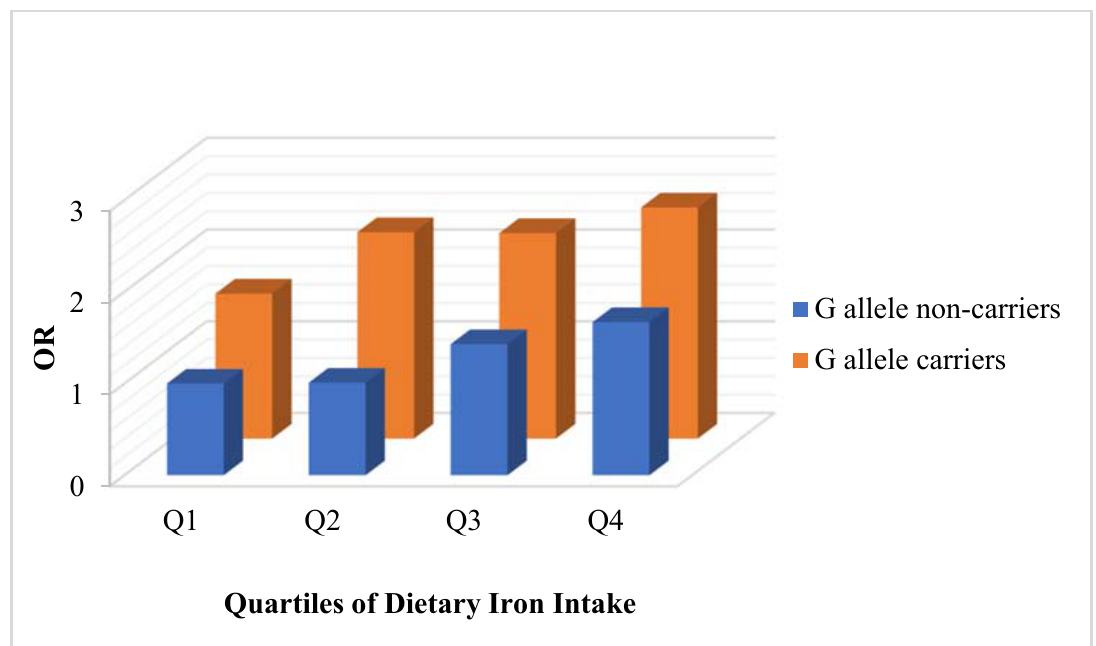
Figure 2. Associations between dietary iron and risk of elevated fasting glucose among all participants stratified by G allele on the rs10830963 site of the MTNR1B gene. Data were presented as ORs for elevated fasting glucose according to the quartiles of dietary iron intake. The subgroup of G allele non-carriers in the lowest quartile of dietary iron intake (<12.82 mg/day) was set to be the reference, meaning OR = 1.00. The other seven subgroups were compared with the reference subgroup.